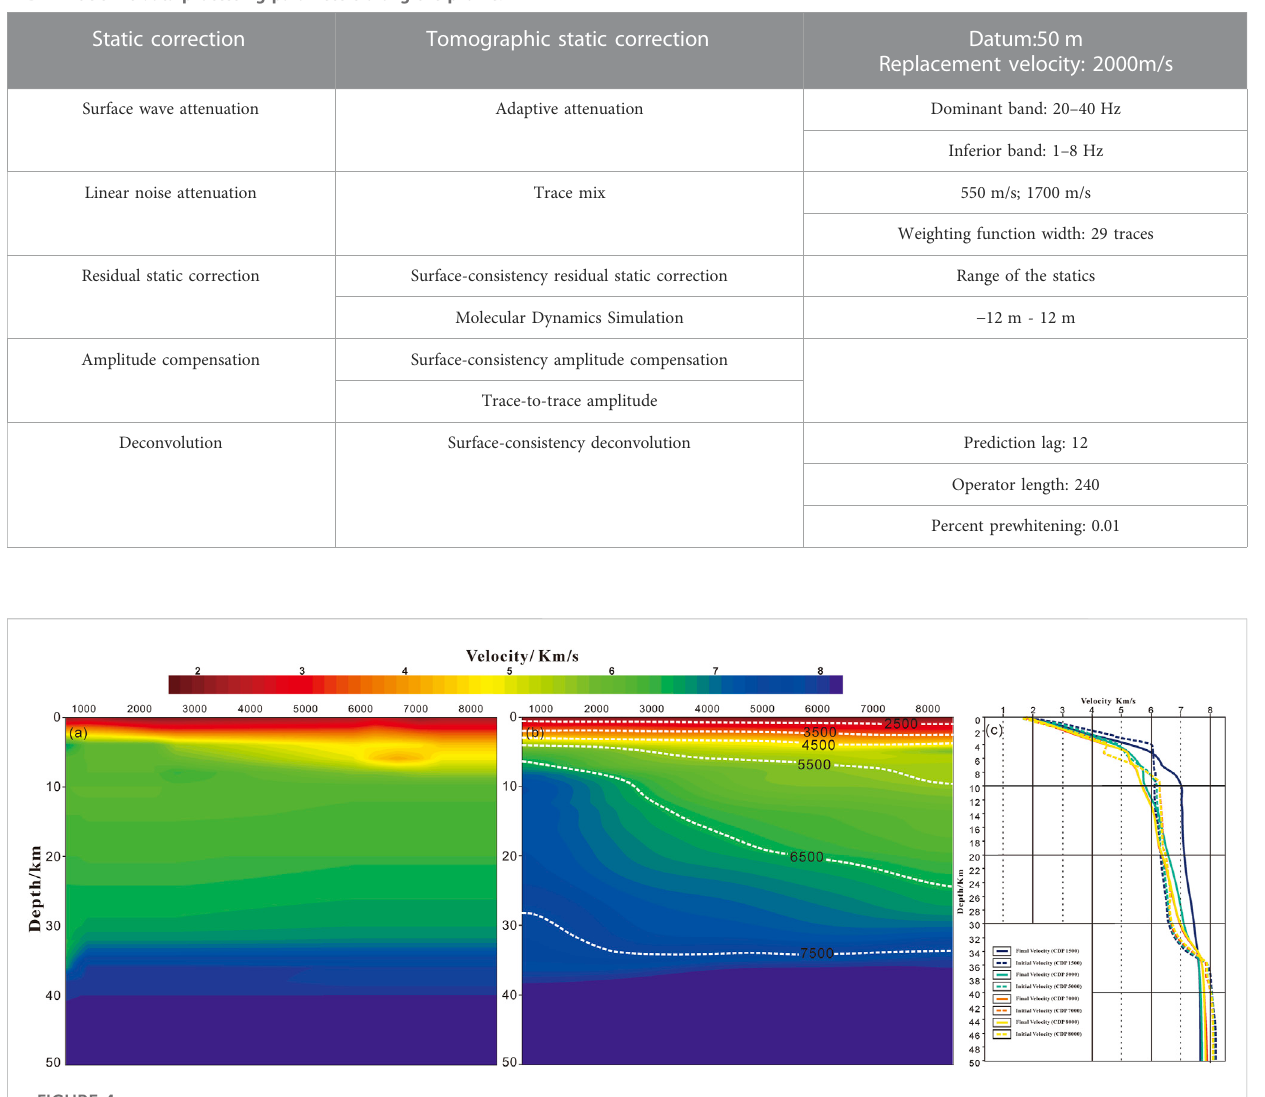
TABLE 2 Seismic data processing parameters along the pro fi le.